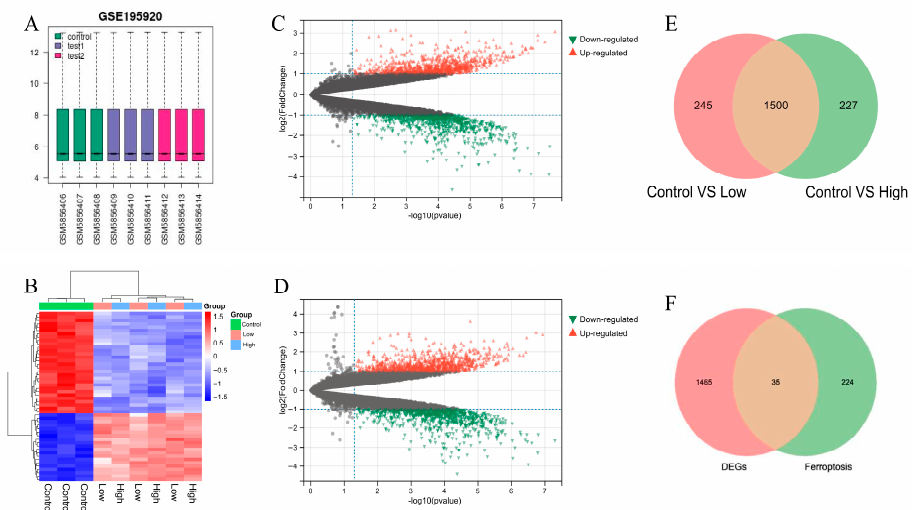
Figure 1. Expression profile of differentially expressed mRNA after fluoride exposure. ( A ) Comparability evaluation of microarray data. ( B ) Heat map of the top 50 DEGs (red: high expression; blue: low expression). ( C , D ) Distribution of DEGs in the volcanic map ( C : control vs. low; D : control vs. high). ( E ) Venn map of differential genes. ( F ) Venn map of ferroptosis-related genes.